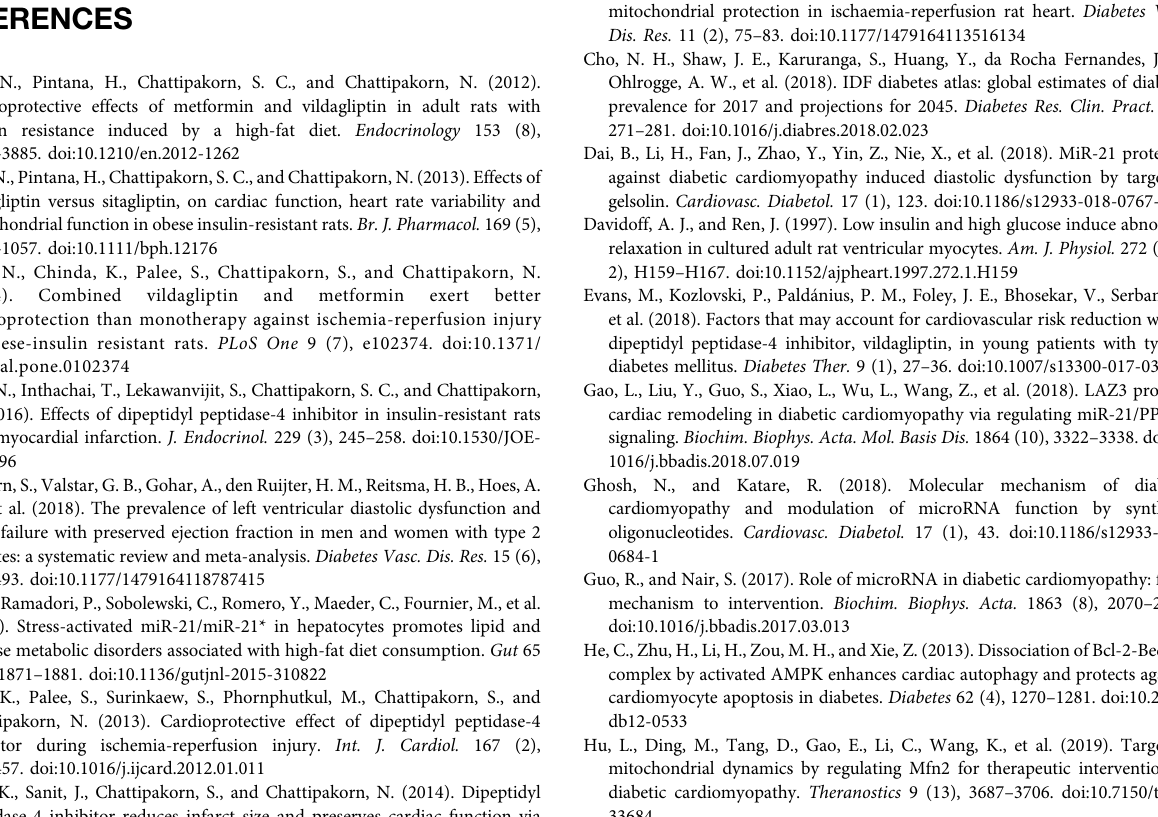
FIGURE S2: Transfection ef fi ciency of adeno-associated virus 9 (AAV9) vector. EGFP expression in frozen sections of the heart was observed under a microscope. FIGURES3: VildregulatedautophagybySPRY1. (A) RepresentativeWBimagesofP62 and Cx43 for different groups after transfection with SPRY1-siRNA. (B) Quanti fi cation P62 and Cx43 protein levels. FIGURE S4: Random blood glucose and OGTT of each group. (A) Random blood glucose in each group at 12 weeks and 22 weeks. (B) OGTT results in mice at 22 weeks. (C) AUCgvaluesdeterminedbyOGTT.Dataarereportedasmean ± SEM.a p < 0.05 vs. NC group; b p < 0.05 vs; c p < 0.05 vs. DM + vild group; d p <